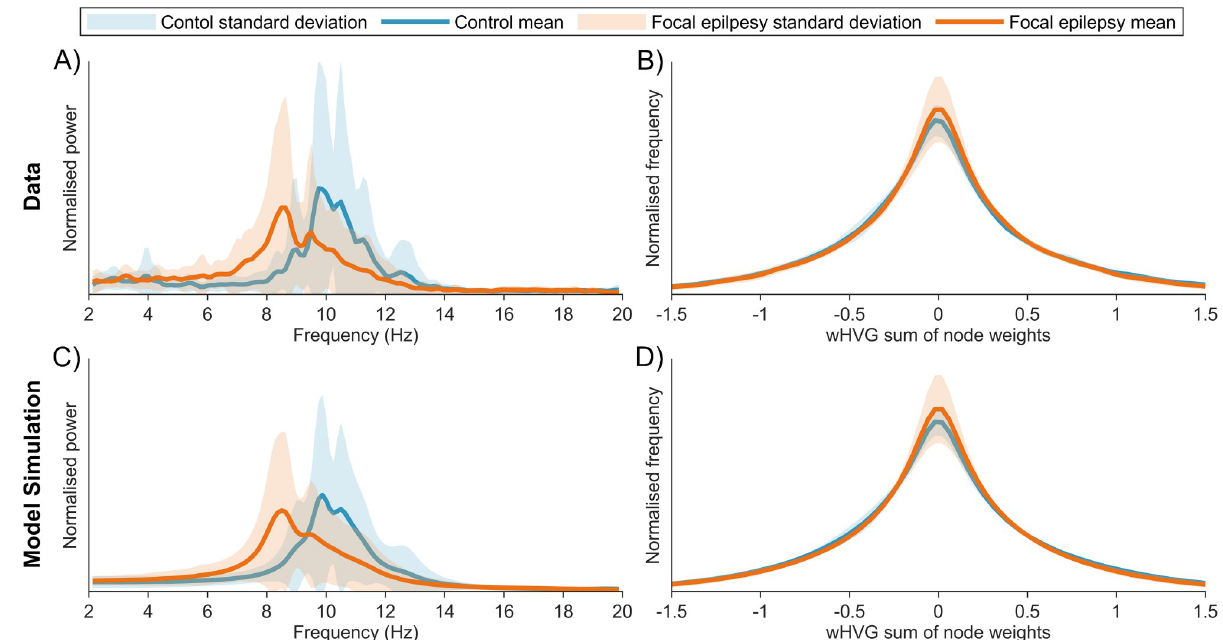
Fig 10. Comparison of data and optimal model simulations for control and FE subjects. A) shows the mean and standard deviation of the PSD across control and FE subjects. B) shows the mean and standard deviation of the wHVG distribution across control and FE subjects. C) and D) give the PSD and wHVG distribution from model simulations at optimal parameter values. Optimal refers to the smallest Euclidean distance from the origin in objective space. Colours as per legend.